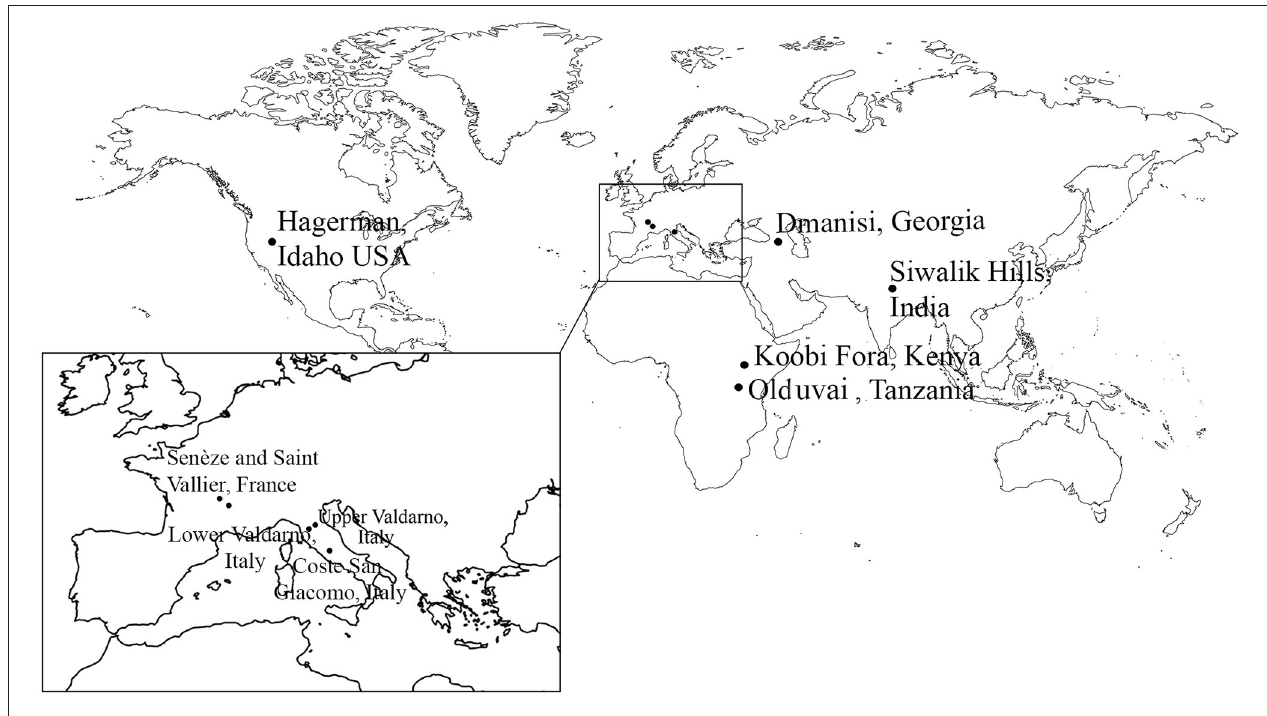
FIGURE 1 | Map of the localities discussed in the text.